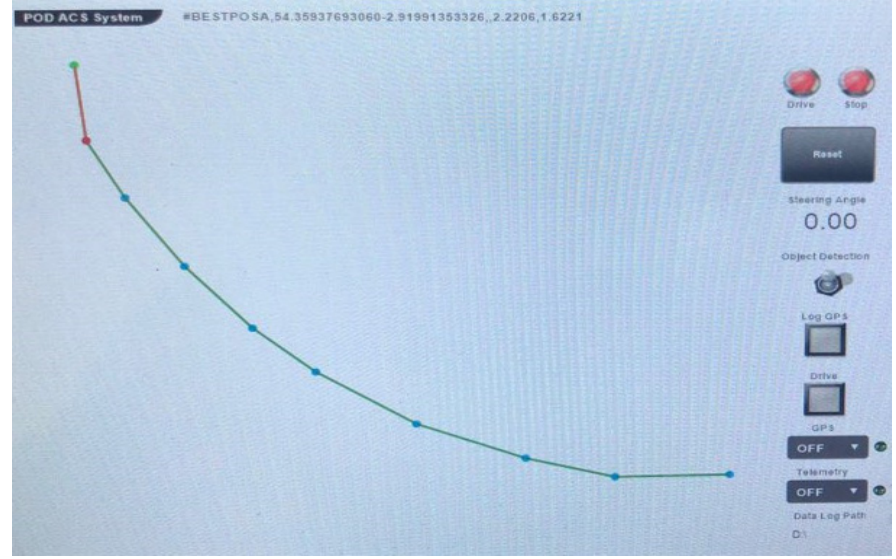
Figure 1. Example of a conventional dynamic map based on GPS waypoint method.